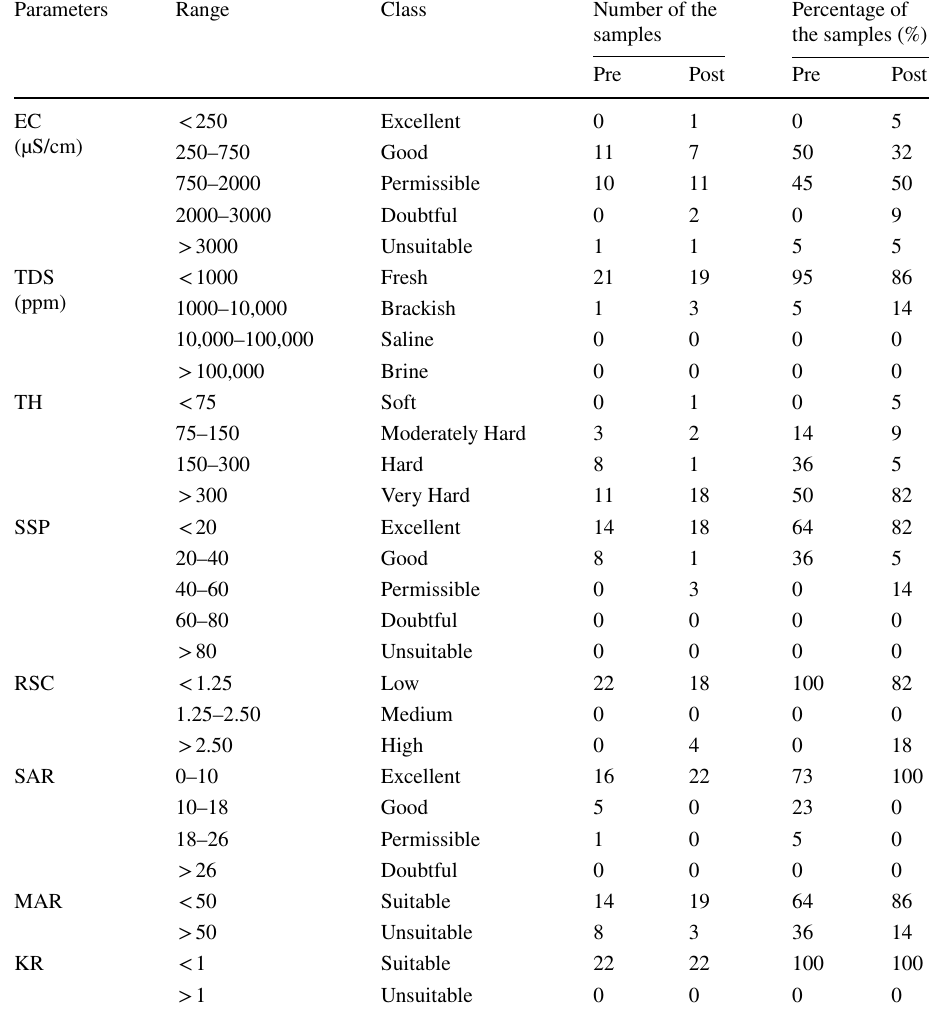
groundwater samples according to the standards of WHO